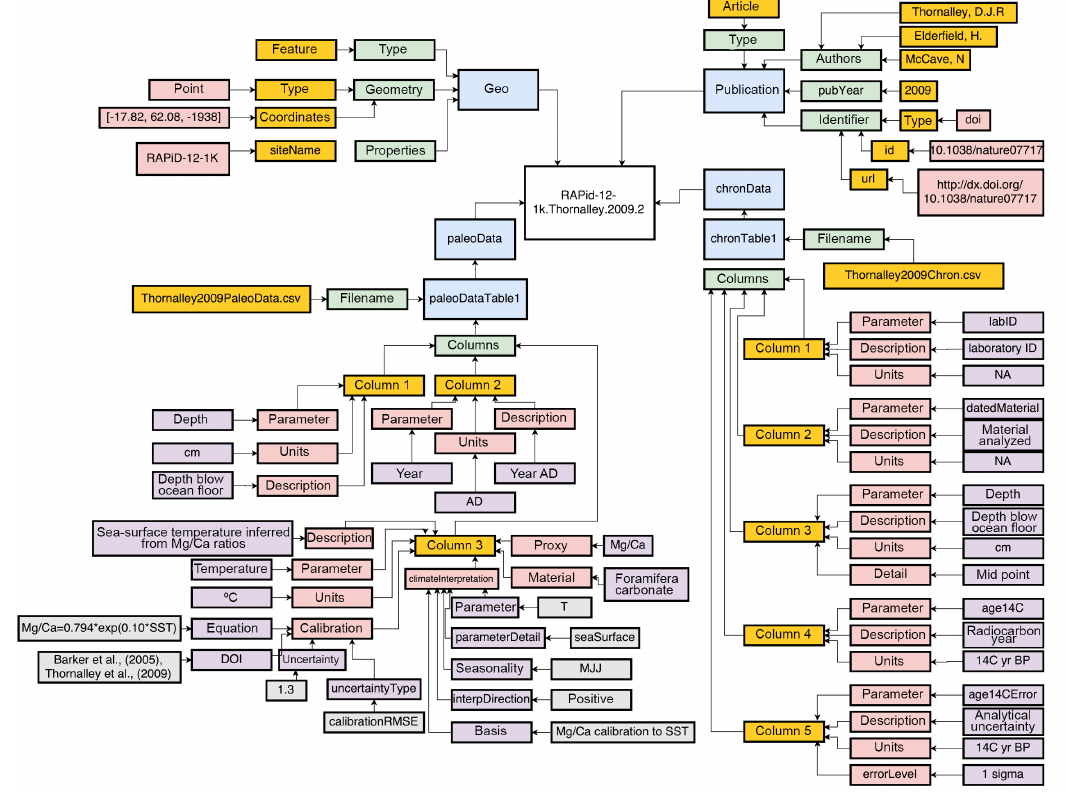
Figure 2. Data model for RAPiD-12-1k example used in the technical note.